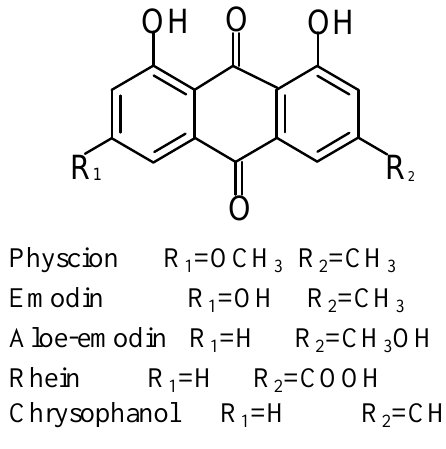
Figure 1. Structures of five compounds in